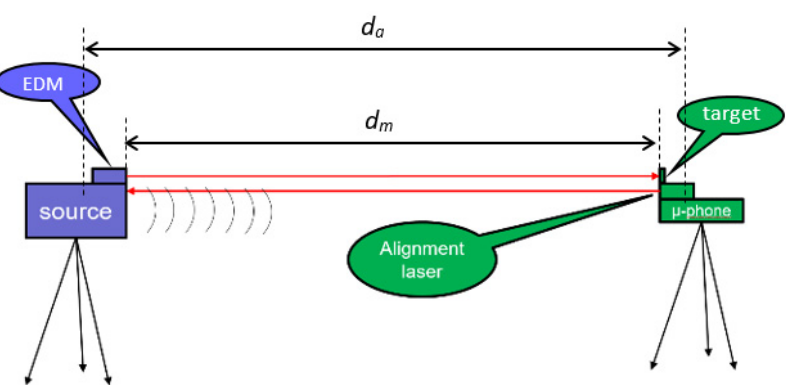
Figure 3. A simplified sketch of the acoustic thermometer. Two tripods are placed at the extremes of the line where the estimation of air average temperature is required. One tripod carries the loudspeaker and the second one a microphone. The distance between the two, d m , is measured with the aid of a calibrated electronic distance meter (EDM) with a relative uncertainty of 10 − 4 . The acoustic distance, d a , is estimated according to Equation (2). An auxiliary laser is placed on the microphone and is used to align it towards the loudspeaker.